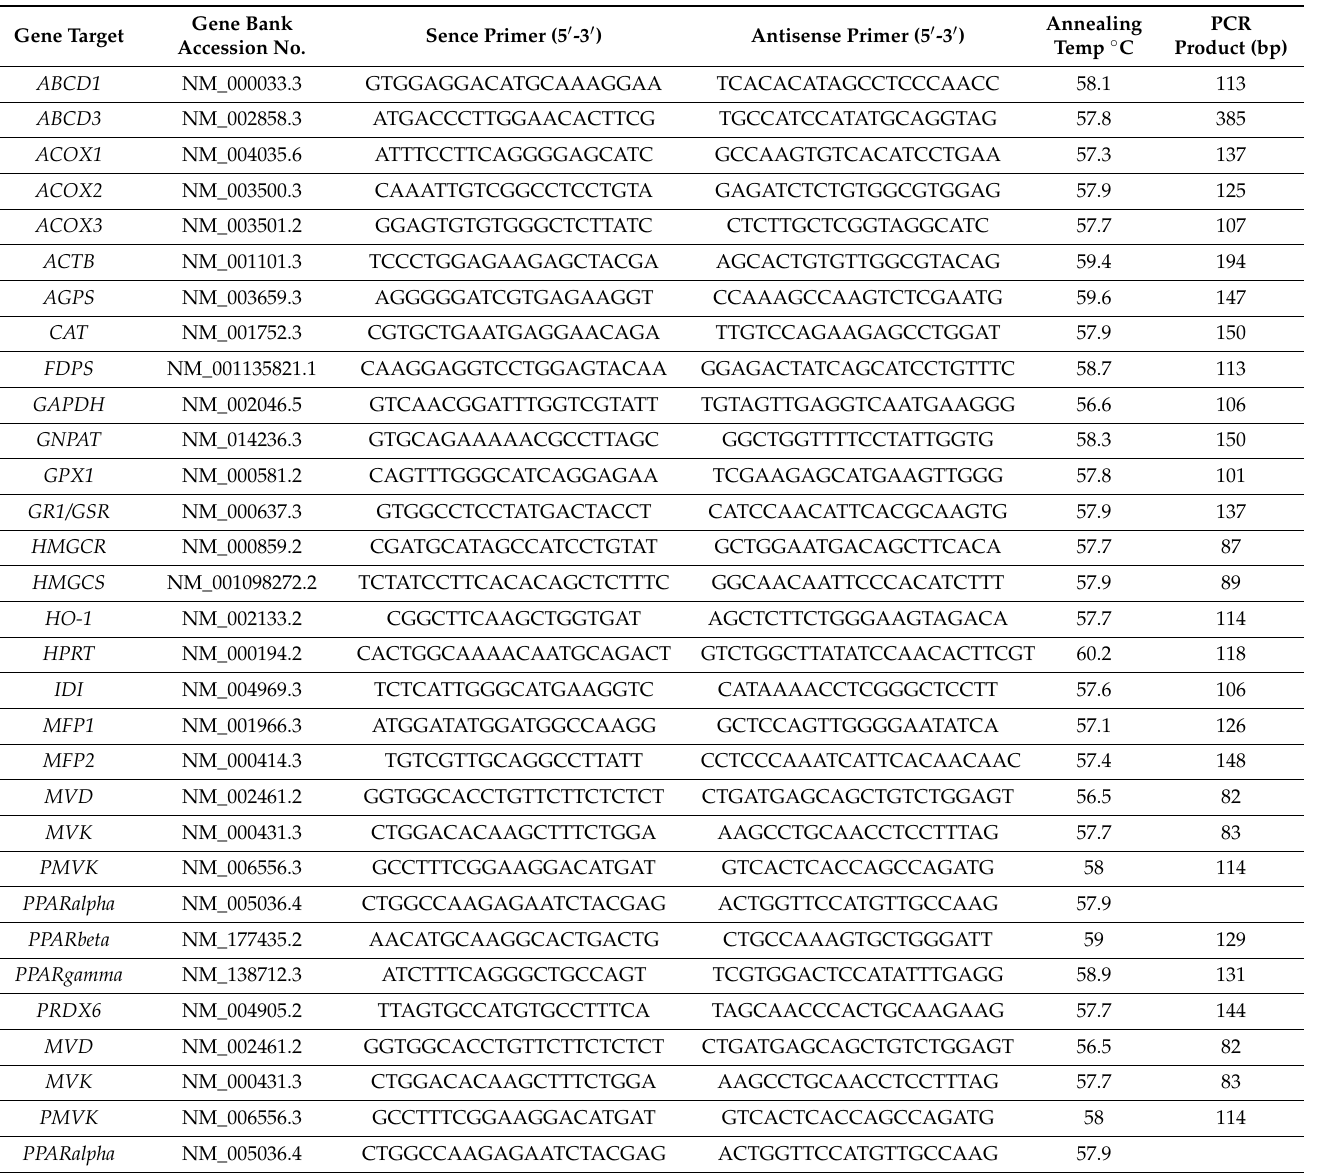
Table 2. List of the human primers used for qPCR